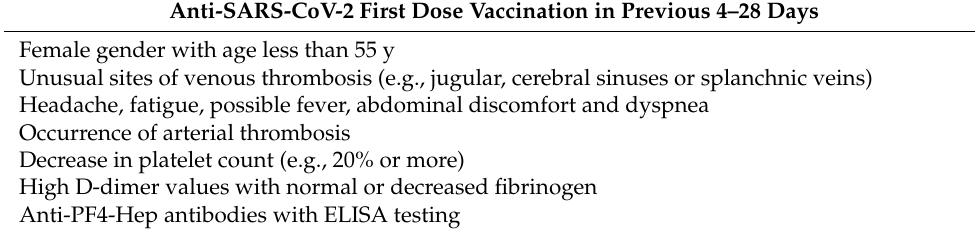
Table 1. Clinical characteristics for suspected VIPIT/VITT.